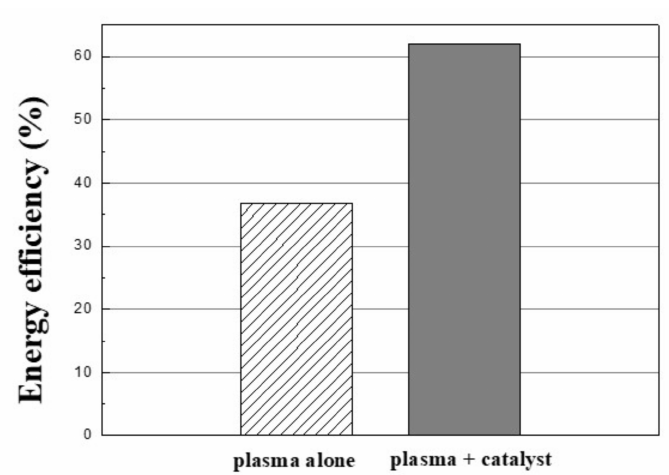
Figure 8. Energy e ffi ciency of dry reforming obtained using the hybrid